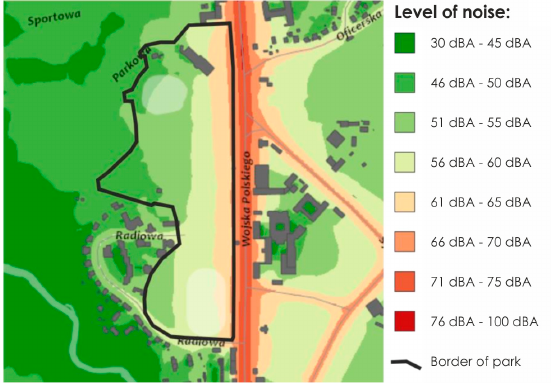
Figure 4. Acoustic map within boundaries of the Jakubowo park. Source: Own elaboration based on Acoustic Map of Olsztyn